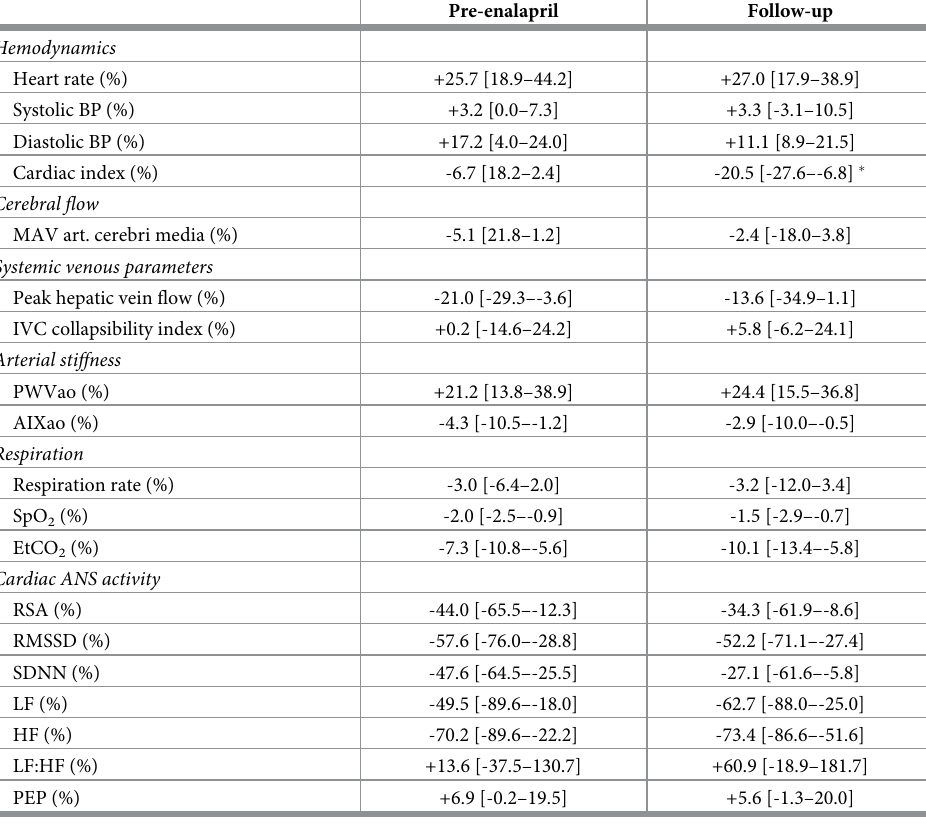
Table 5. Percentage change of parameters during head-up tilt in Fontan patients before enalapril treatment and at